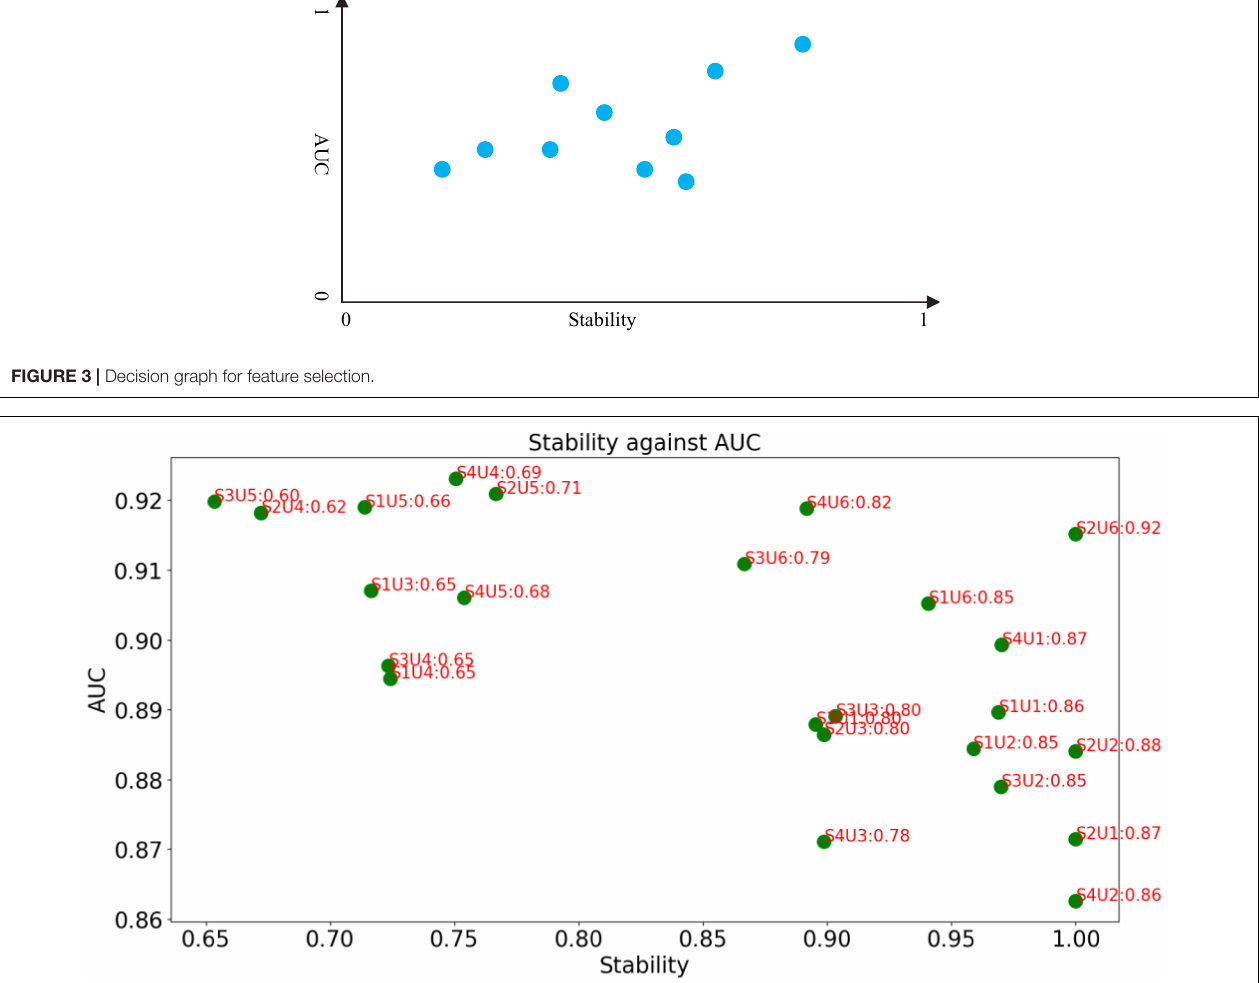
FIGURE 4 | Decision graph for MRI